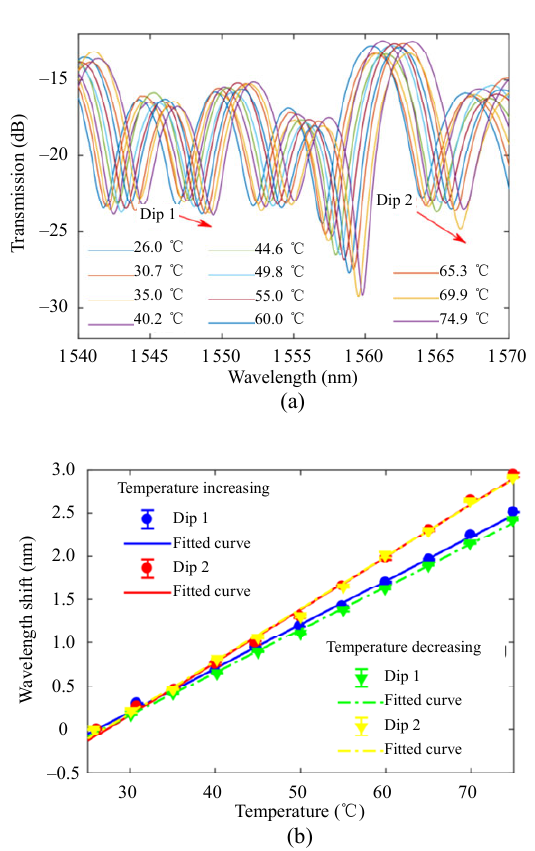
Fig. 6 Temperature sensing experimental results: (a) spectrum shift of the sensor in one of the heating tests and (b) relationship between the ambient temperature and the average wavelength shifts of Dip 1 and Dip 2 in heating and cooling experiment.